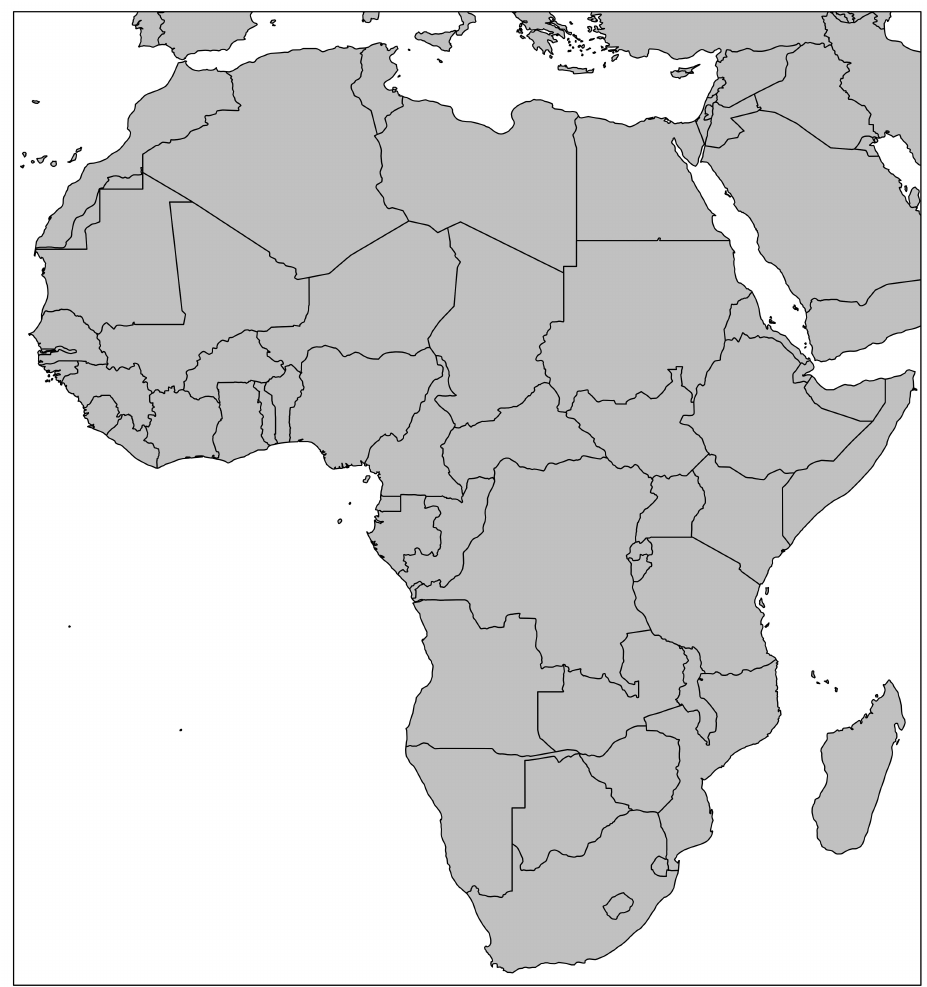
Figure 1. Map of the study